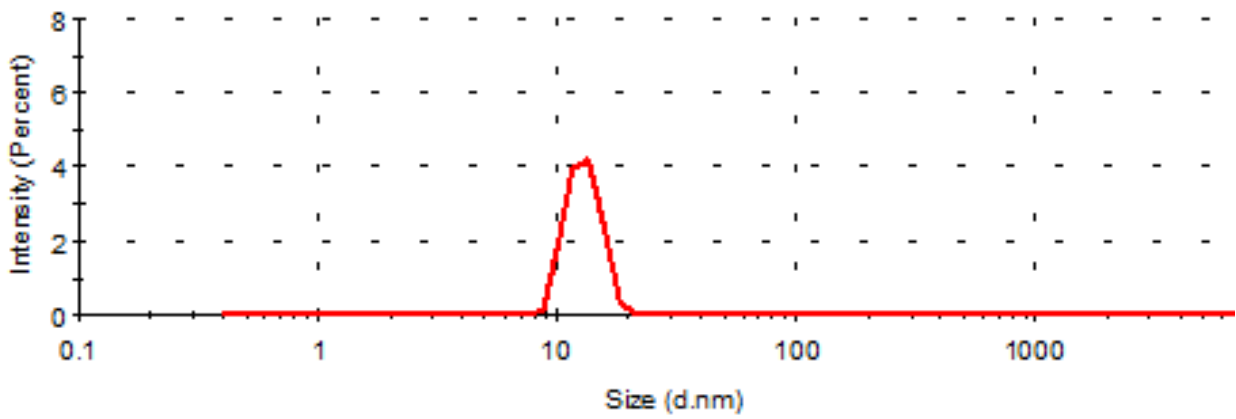
Figure 2. Evaluation of emulsion size.